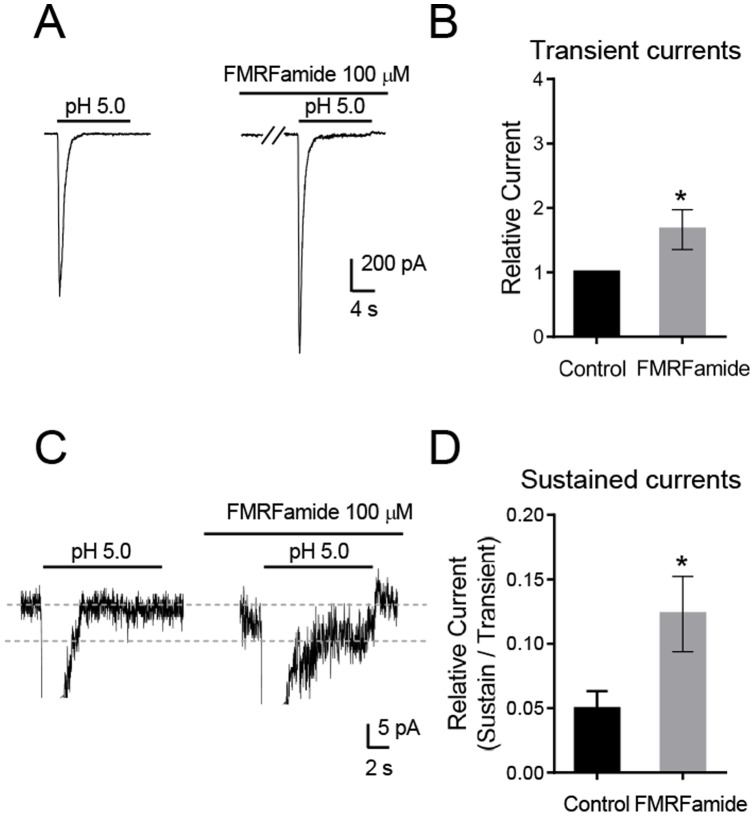
Effects of FMRFamide on ASIC currents in freshly isolated anterior pituitary cells.
A, C. Representative traces of pH 5.0 activated ASIC currents, with and without 30 second pretreatment with 100 µM FMRFamide. FMRFamide potentiated the pH 5.0 induced peak (A) and sustained (C) currents. B, D. Average data showing potentiation of current by FMRFamide as shown in A and C (n = 7). * P<0.05, Student's t-test.